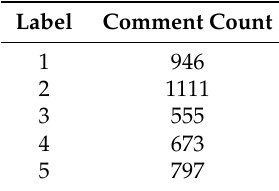
Table 3. Number of comments in each label category for the Devanagari dataset.